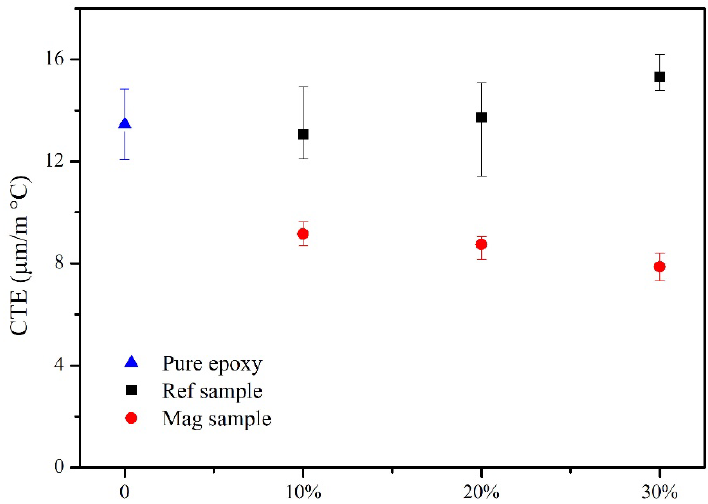
Figure 10. CTE of pure epoxy and the NiGNT–epoxy composites with different ratios.